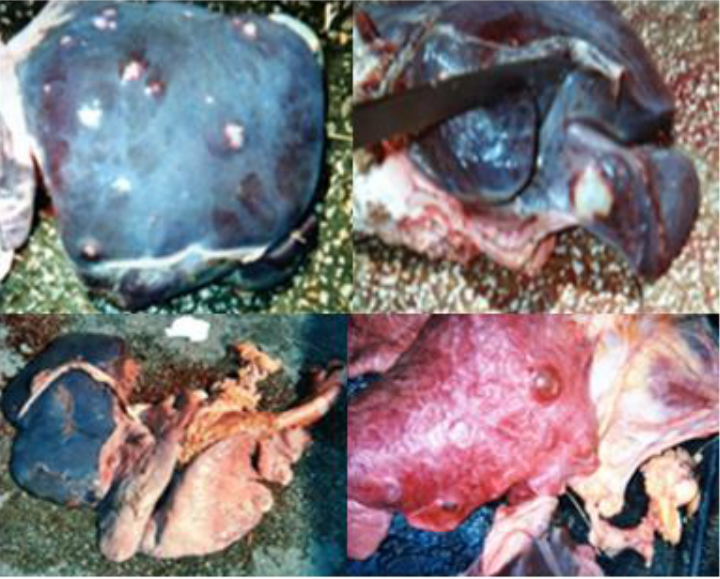
Figure 6. Pericarditis (Pale, sometimes whitish edematous pericardium).